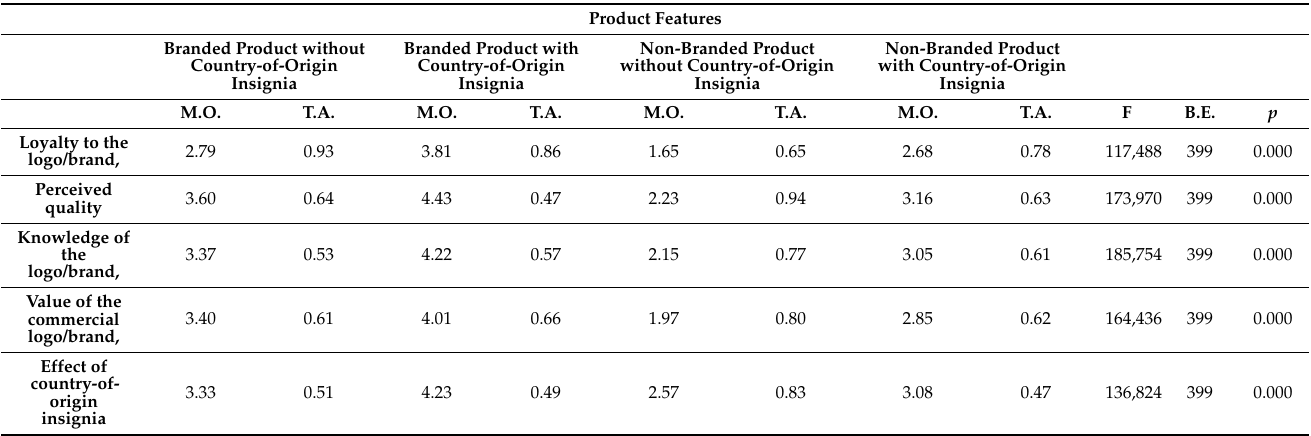
Table 3. Results of the One-Way Analysis of Variance